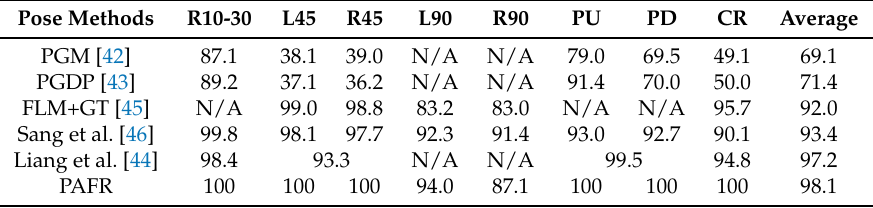
Table 5. Comparison with